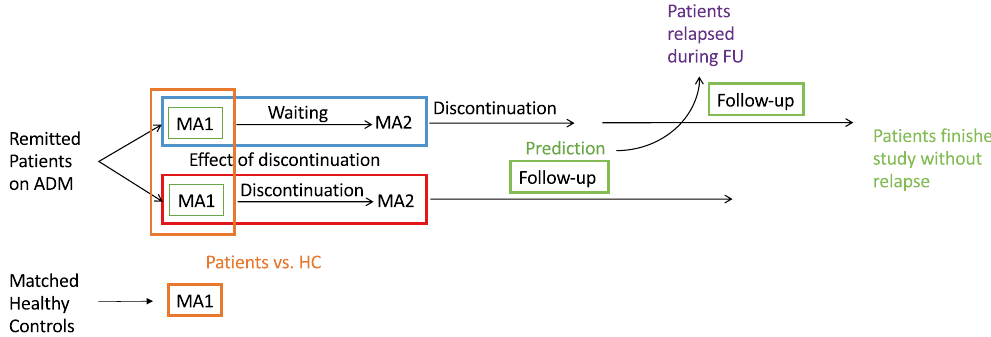
Figure 1. Study design: we recruited remitted, medicated patients on antidepressant medication (ADM) and matched healthy controls (HC). They were assessed and compared at main assessment 1 (MA1) to identify traits characterising the remitted, medicated state. Next, patients were randomised to either discontinue their medication before MA2 (bottom arm, “discontinuation group” or enter a waiting period while continuing their ADM matched to the length of discontinuation time (top arm, “waiting group”). Differences in changes between MA1 and MA2 in the two separate groups were investigated to gain an understanding of the effects underlying discontinuation. Patients in the waiting group discontinued their ADM after MA2. After discontinuation, all patients entered the follow-up (FU) period of 6 months, whereas some patients had a relapse during this period and some patients finished this period without relapse. Differences in characteristics at MA1 of patients who relapsed and patients who did not relapse during FU provide information on which variables relates to relapse risk and can be used to identify predictors of relapse after ADM